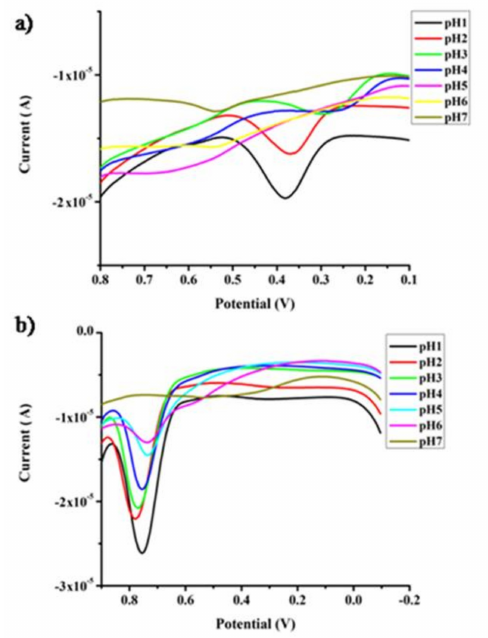
Figure 5. DP voltammogram of 10 − 2 M ( a ) Cys and ( b ) Met at CNOs–PS / Pt electrode in di ff erent pHs at a scan rate of 0.1 V / s.